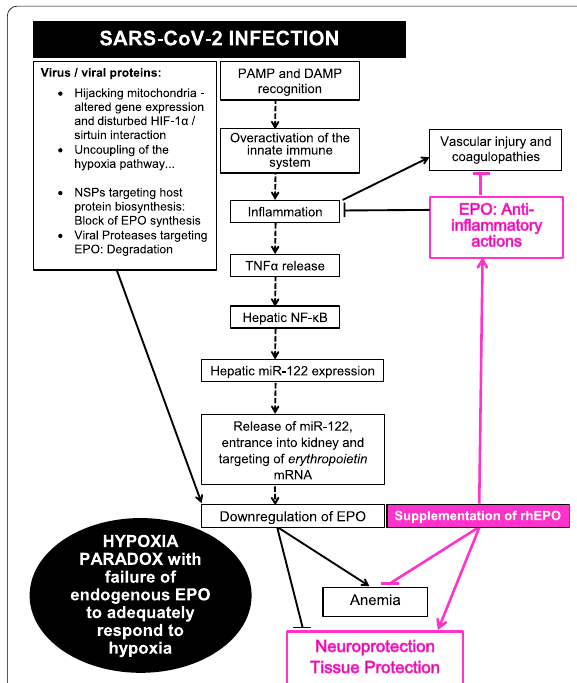
Fig. 1 Suppression of EPO expression as a consequence of SARS-CoV2 infection and the rationale for rhEPO supplementation. Putative action of viral nonstructural proteins (NSP) and viral proteases on host protein biosynthesis and stability of host proteins (see text for references and details). Failure of EPO response to hypoxia may result in anemia and enhanced tissue/brain/ neural injury. External EPO or EPO biosimilars are expected to combat anemia, reconstitute neuroprotection and tissue protection and mediate beneficial immune modulation. PAMP (pathogen-associated molecular pattern) and DAMP (damage-associated molecular pattern) recognition can induce primary and secondary cytokine storms, respectively. EPO suppression by TNFα and by TNFα/ NF-κB-mediated induction of miR-122 has been demonstrated under various inflammatory conditions (Cluzeau et al. 2017; Rivkin et al. 2016). Anti-inflammatory actions, vascular protection and beneficial effects of EPO on respiratory functions have been reviewed in